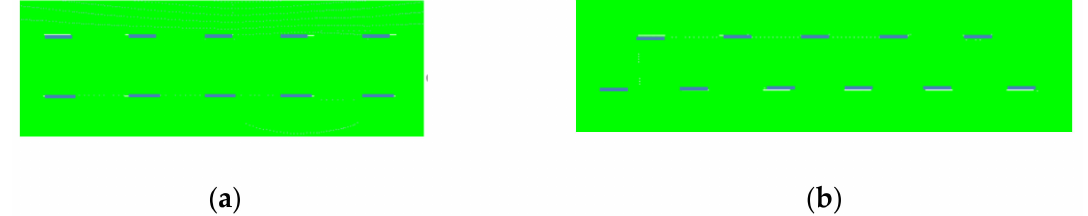
Figure 12. Two different arrangements of wind turbine rows: ( a ) 5 turbines that are placed directly behind the turbines of the first row; ( b ) 6 turbines that are facing the gaps between the turbines of the first row.